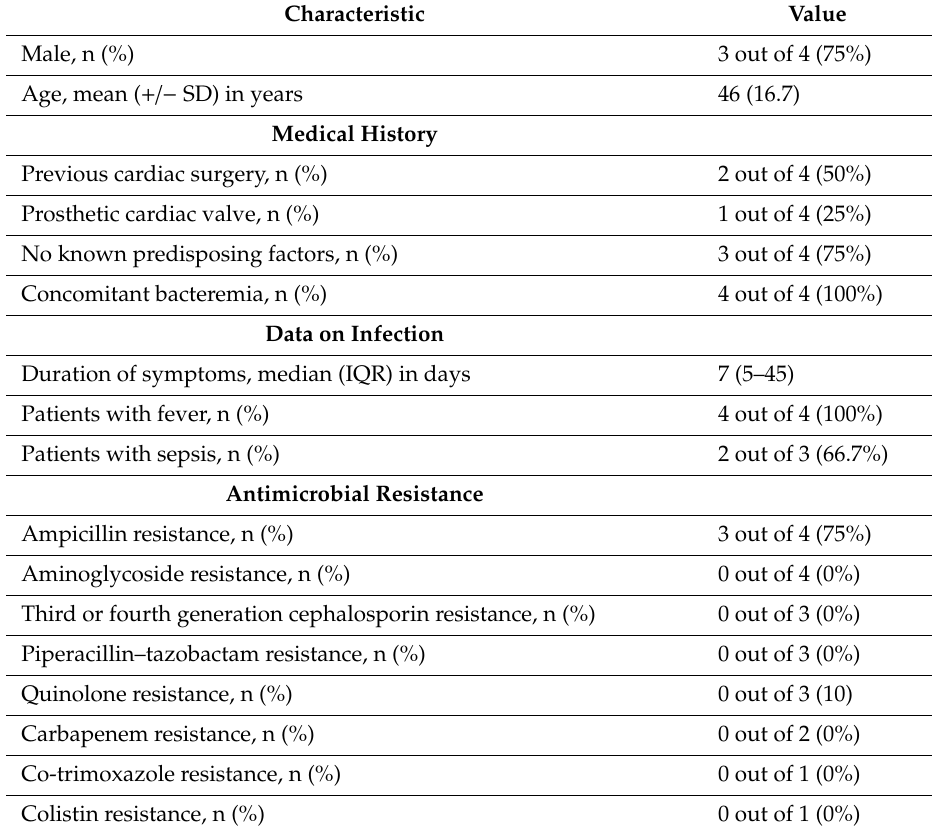
Table 2. Characteristics of four patients with infective endocarditis by Pseudomonas mendocina